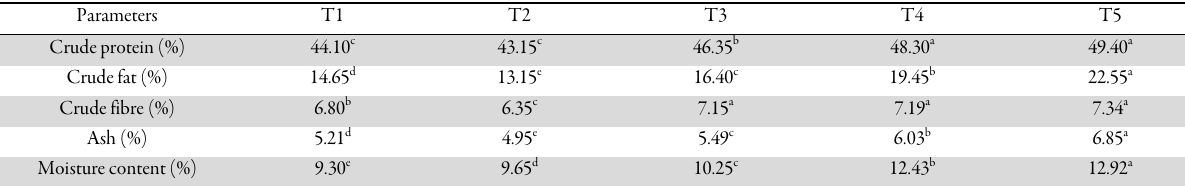
Table 3. Proximate composition of the feed Parameters